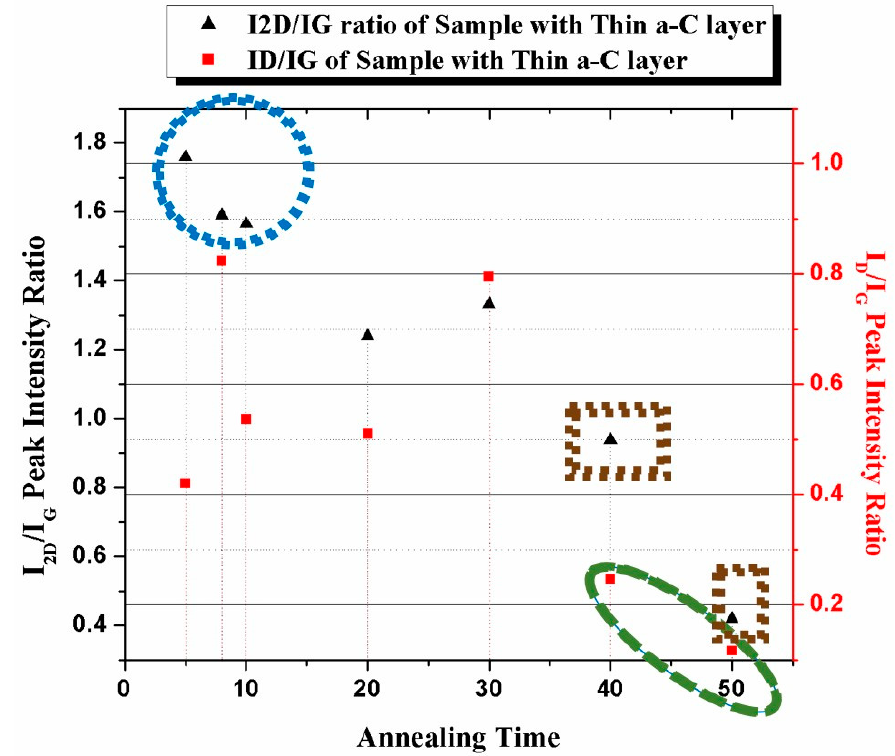
Figure 10. Plots of the I D / I G and I 2D / I G peak intensity ratios vs. annealing time, for samples with a thin a ‐ C layer annealed at 1020 °C. The dotted circle shows the region with a larger I 2D / I G peak intensity ratio at a shorter annealing times. Dotted rectangles show the region with a smaller I 2D / I G peak intensity ratio, and the dashed oval shows the region with a smaller I D / I G peak intensity ratio, both at longer annealing times.